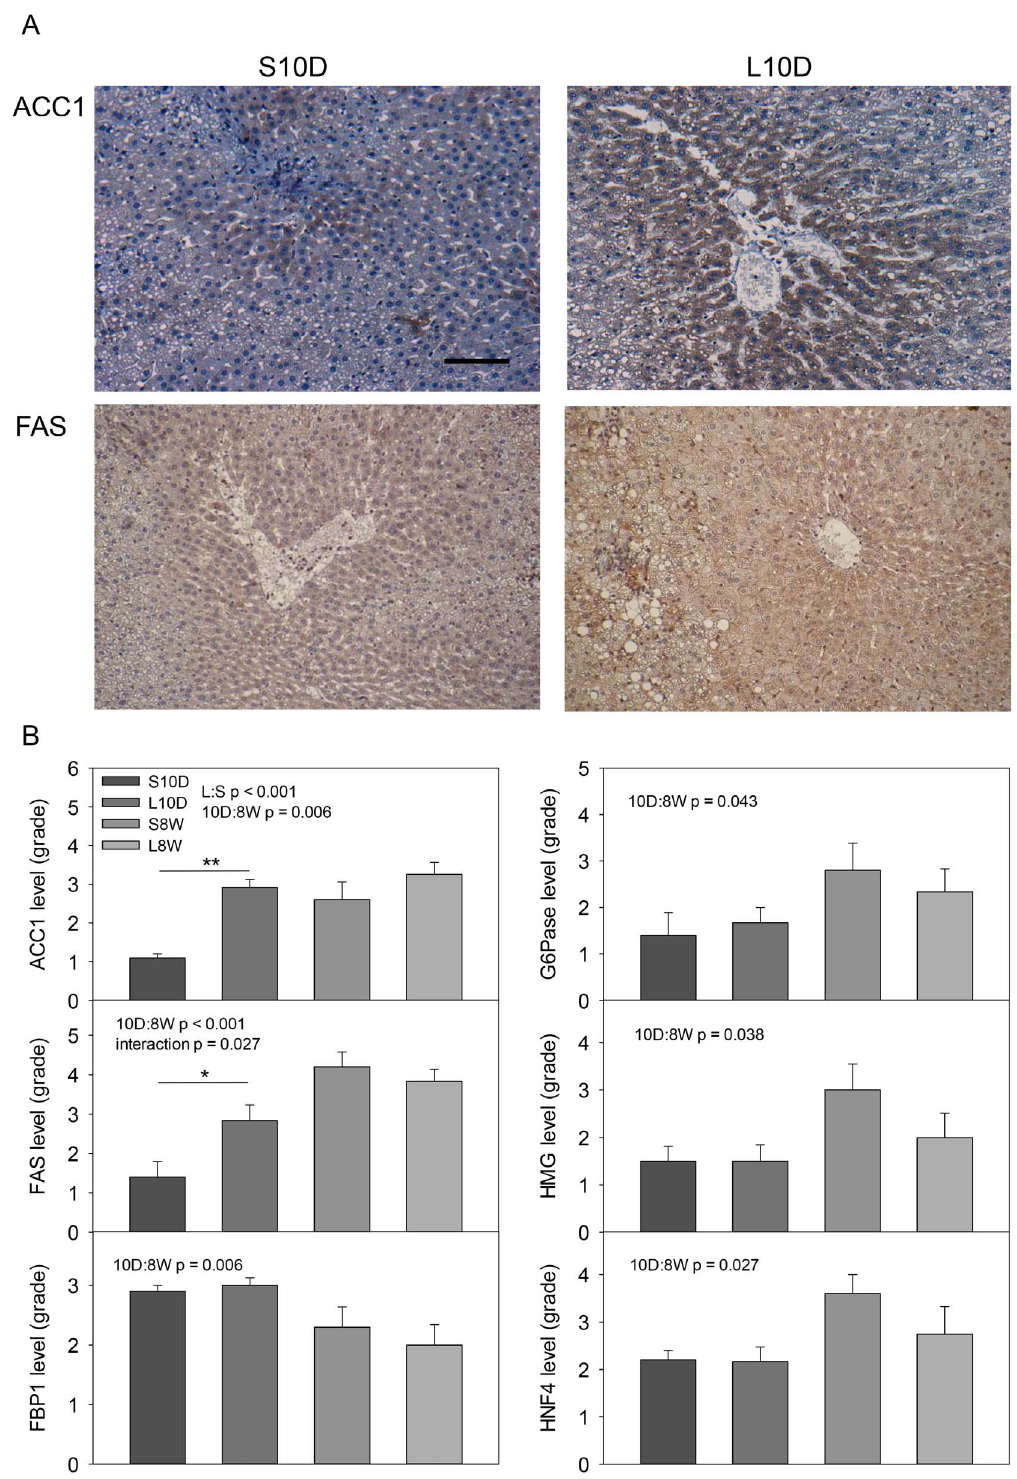
Figure 5. Short and long-term effects of lipectomy on hepatic protein levels in obese rats. Immunohistochemical analysis was performed on formalin-fixed Paraffin-embedded liver tissues collected from lipectomized (L10D and L8W) and sham-operated (S10D and S8W) rats. (A) Representatives of liver sections detected with ACC1 or FAS primary antibody on S10D and L10D samples. (B) Quantitative data of the IHC results scored as 5 grades. The significant p value of Two-way ANOVA analysis for an effect of lipectomy and sham operation (S:L), 10 day and 8 week time point (10D:8W) and interaction between two factors on a parameter was shown. * p , 0.05, ** p , 0.01: Two-way ANOVA Holm Sidak posthoc analysis of significant difference. The scale bar represents 100 m m.